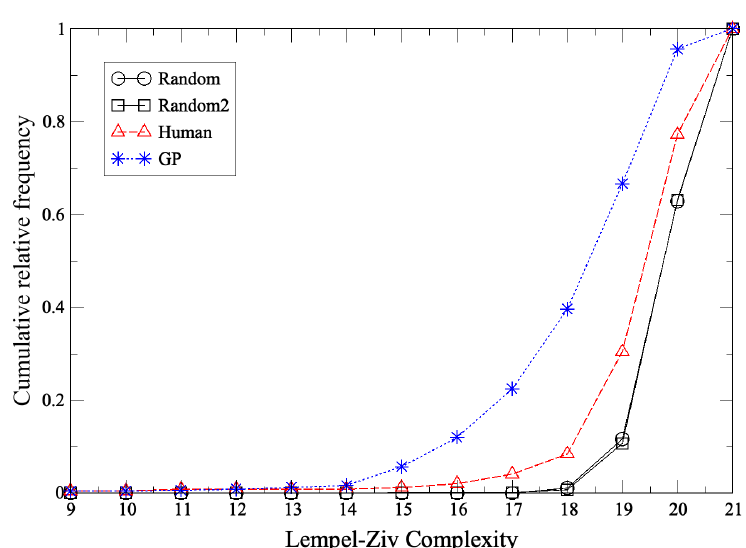
Figure 6. Cumulative relative frequency distribution of Lempel–Ziv complexity obtained from the set of RPS time series. The RPS time series were generated by a pseudorandom set, human, and the strategy inferred by GP. Here, “Random” and “Random2” show the results from the sets of 500 and 10 8 pseudorandom series generated using the Mersenne Twister, respectively.